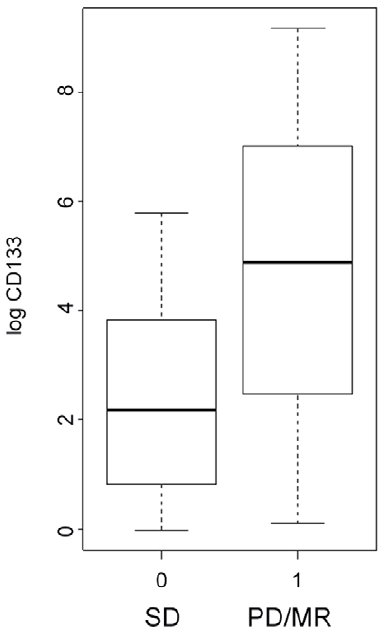
Figure 1. Bivariate relationships of log CD133 mRNA and disease outcomes. Patients with progression disease and mix response had higher CD133 mRNA level than patients with stable